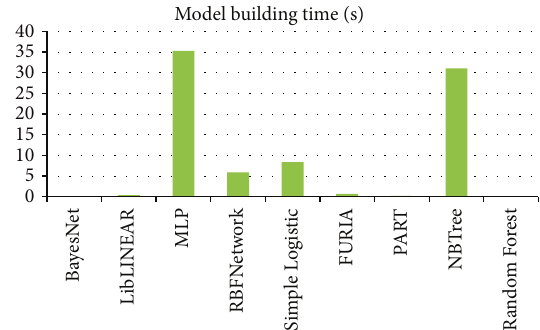
Figure 11: Comparison of model building time by different classi-